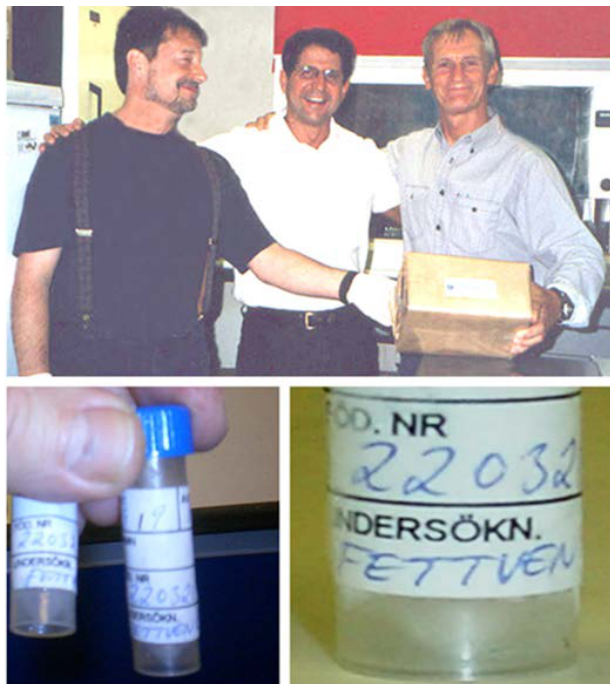
Fig. 5 - A delivery of ‘FETTVEN’. Top: Domingos Souza (middle) delivers samples of saphenous vein collected in Örebro. Andrzej Loesch (left) and Mick Dashwood (right) accept this gift. Lower left: Tubes containing saphenous vein samples. Lower right: No-touch saphenous vein tube labelled